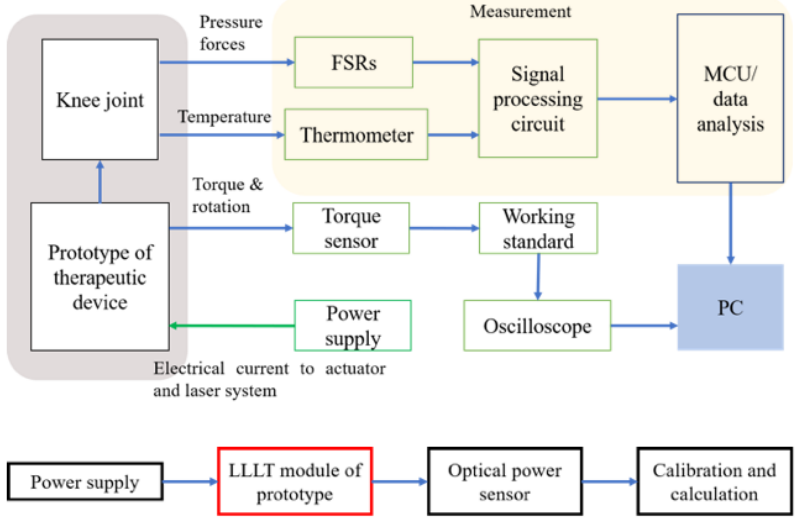
Figure 4. Treatment stimulator test protocols.